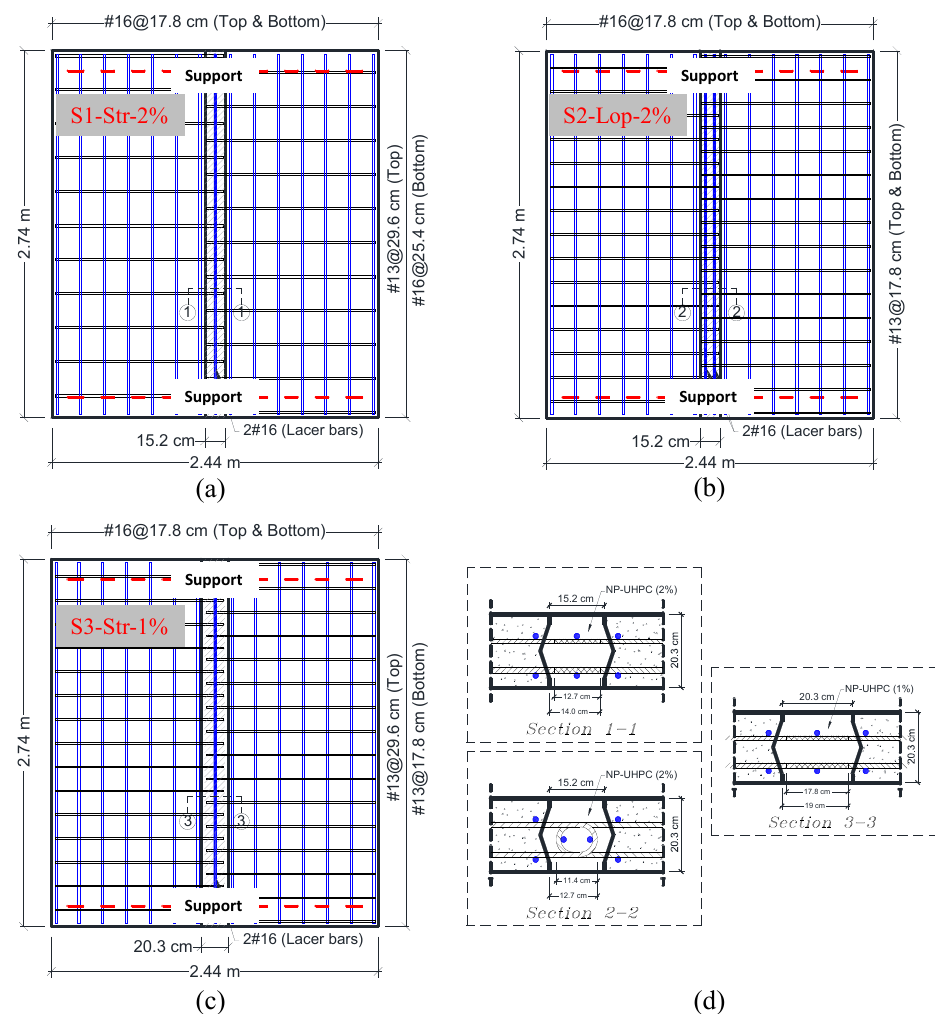
Figure 3. Overall dimensions and structural design details of specimens ( a ) S1-Str-2%; ( b ) S2-Lop-2%; ( c ) S3-Str-1%; ( d ) close-up view of the field joint details.